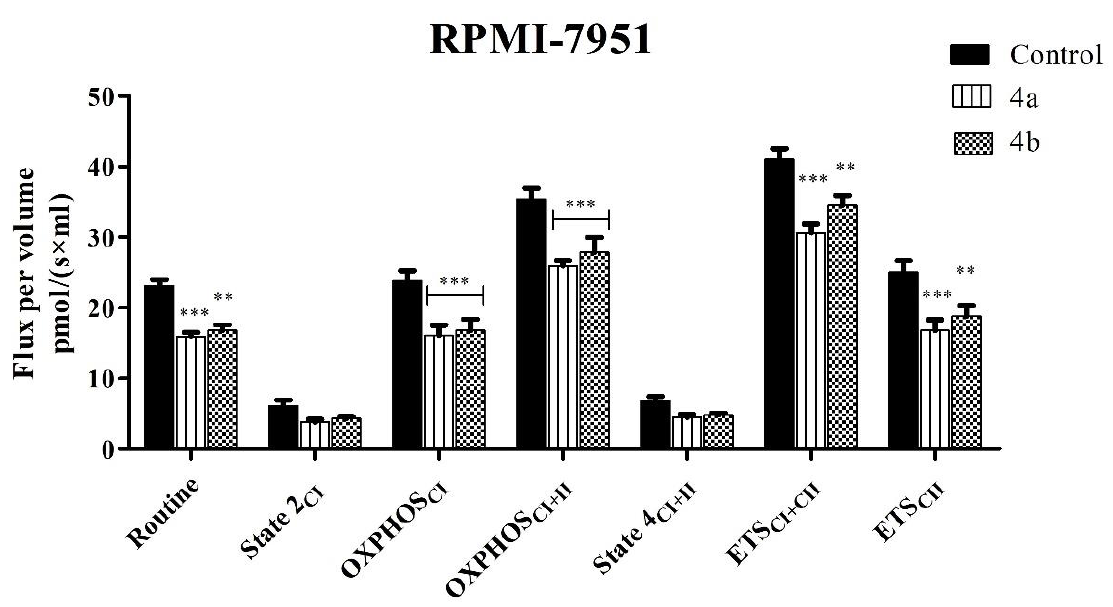
Figure 8. The rates of mitochondrial respiration in permeabilized RPMI − 7951 cells after treatment with compounds 4a and 4b (tested at IC 50 : 18.8 µ M and IC 50 : 20.7 µ M, respectively) for 48 h. All experiments were repeated five times and the results are reported as mean values ± SD. One − way ANOVA followed by Bonferroni’s post − test were used in order to identify statistical differences vs. control (** p < 0.01 and *** p <